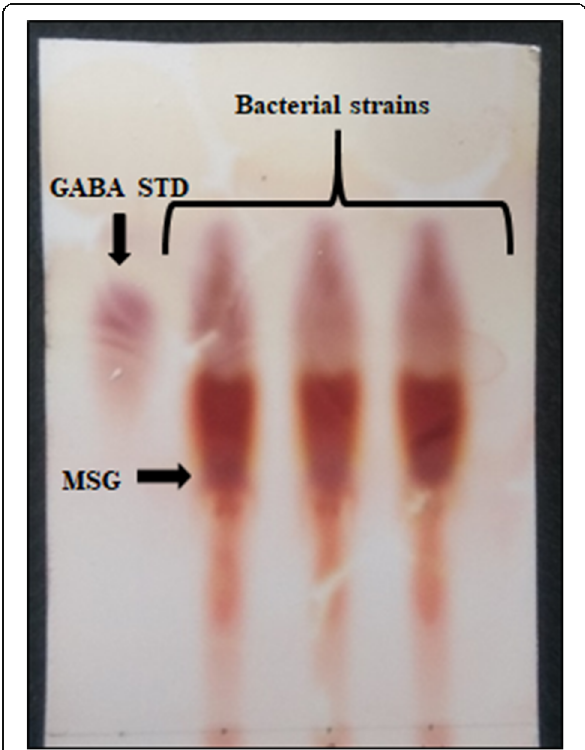
Fig. 1 Qualitative detection of GABA (red color spots) produced by bacterial strains on TLC